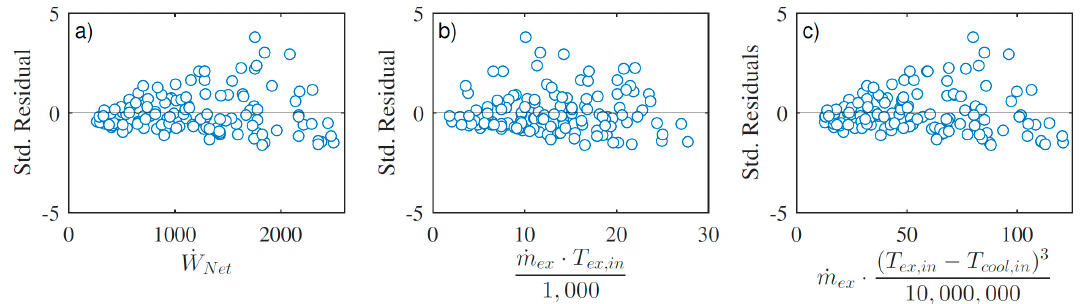
Figure 7. Design regression model #1, standard residuals distribution according to the target data and regression parameters. Energies 2020 , 13 , x FOR PEER REVIEW